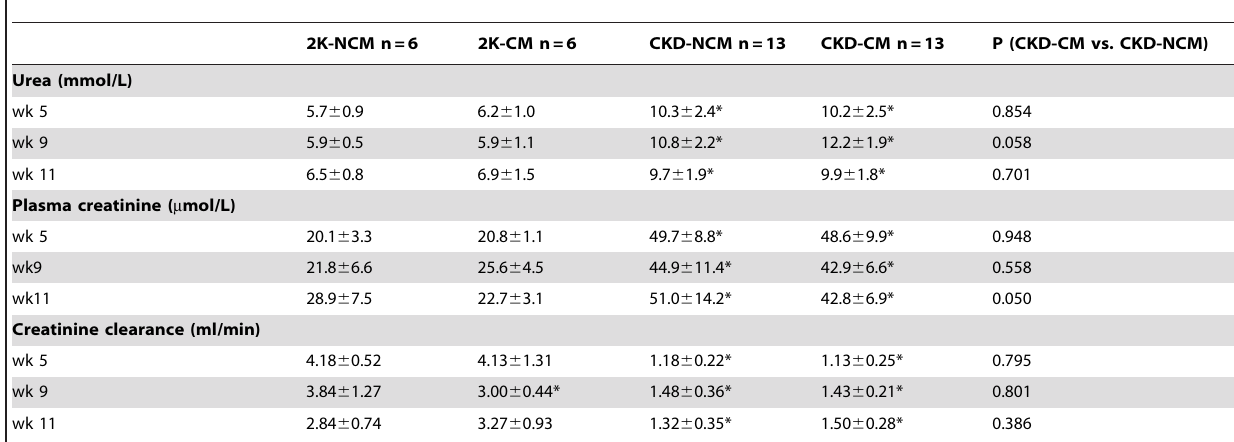
Table 2. Longitudinal measurements after CM treatment at week 6 after